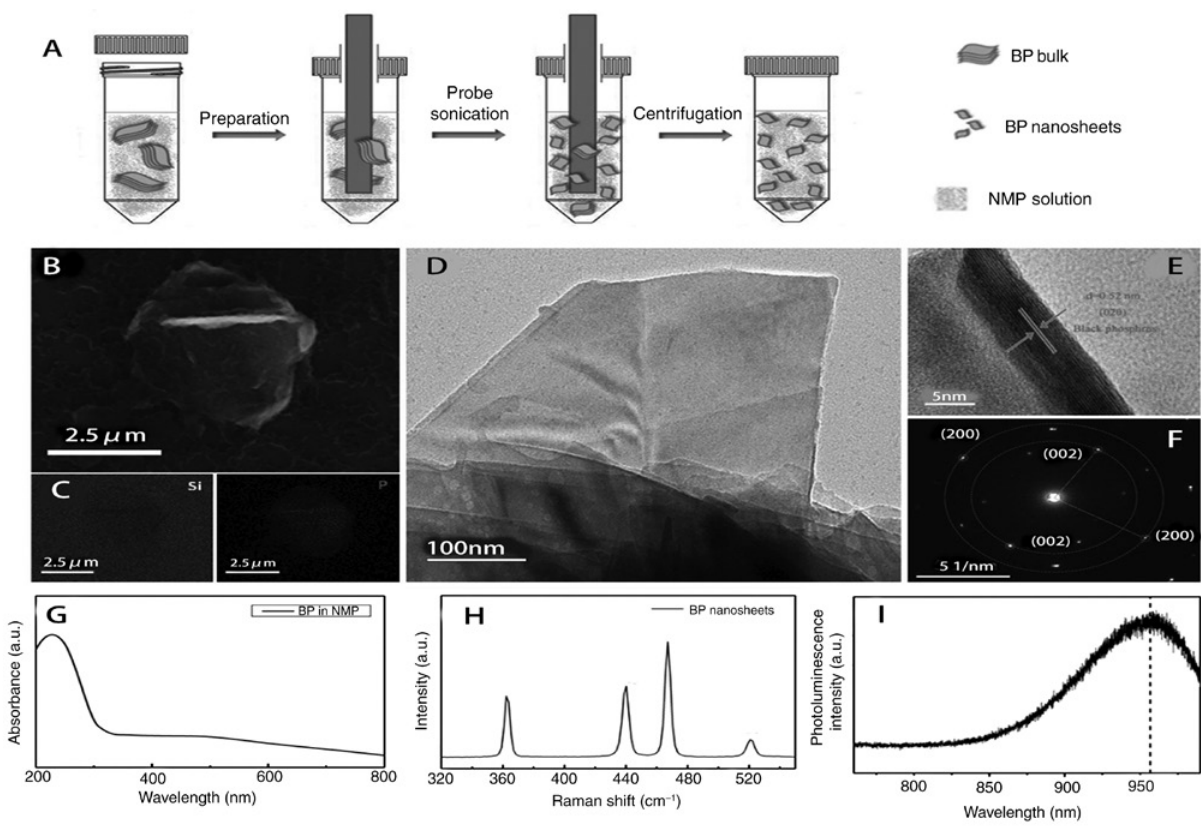
Figure 3: Investigation of BP’s optical property. (A) Schematic illustration of the proposed solution-phase exfoliation route for BP nanosheets. (B) Scanning electron microscopy (SEM) image. (C) EDS image. (D) Transmission electron microscopy (TEM) image. (E) High-resolution TEM (HRTEM) image. (F) Selected area electron diffraction (SAED) pattern of exfoliated BP. (G) UV-visible spectra of BP/NMP (inset: optical image of BP/NMP solution). (H) Raman spectra of bulk BP and exfoliated BP nanosheets on SiO /Si substrate. 2 (I) Photoluminescence spectra of exfoliated BP nanosheets on SiO /Si substrate. Reproduced with permission from Ref. 2